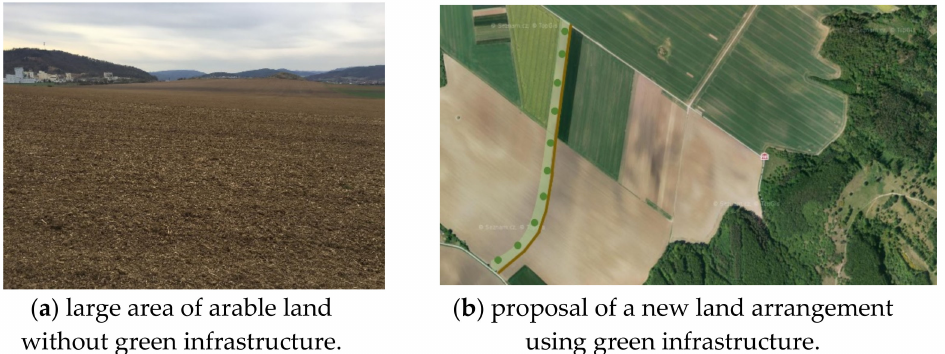
Figure 10. ( a , b ) Example of submitted proposals for dealing with the problematic areas. Source: photographed and elaborated by pupils of the participating school (a grammar school in